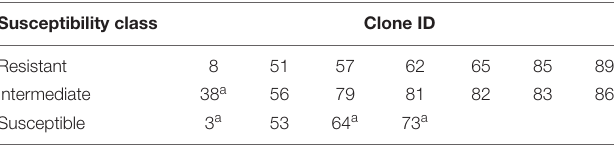
TABLE 1 | Ash clones sampled within each susceptibility class at Snogeholm and Trolleholm seed